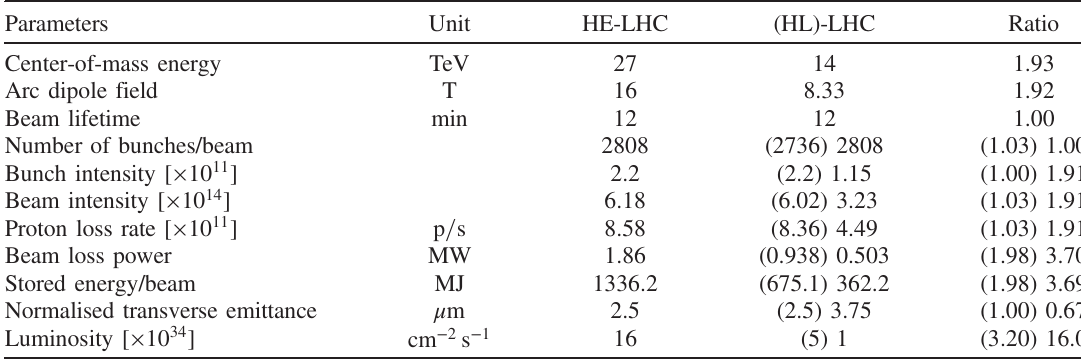
TABLE I. Main design parameters for HE-LHC [3], HL-LHC [7] and LHC [5]. The luminosity refers to a leveled value for HL-LHC and to the peak for HE-LHC and LHC.